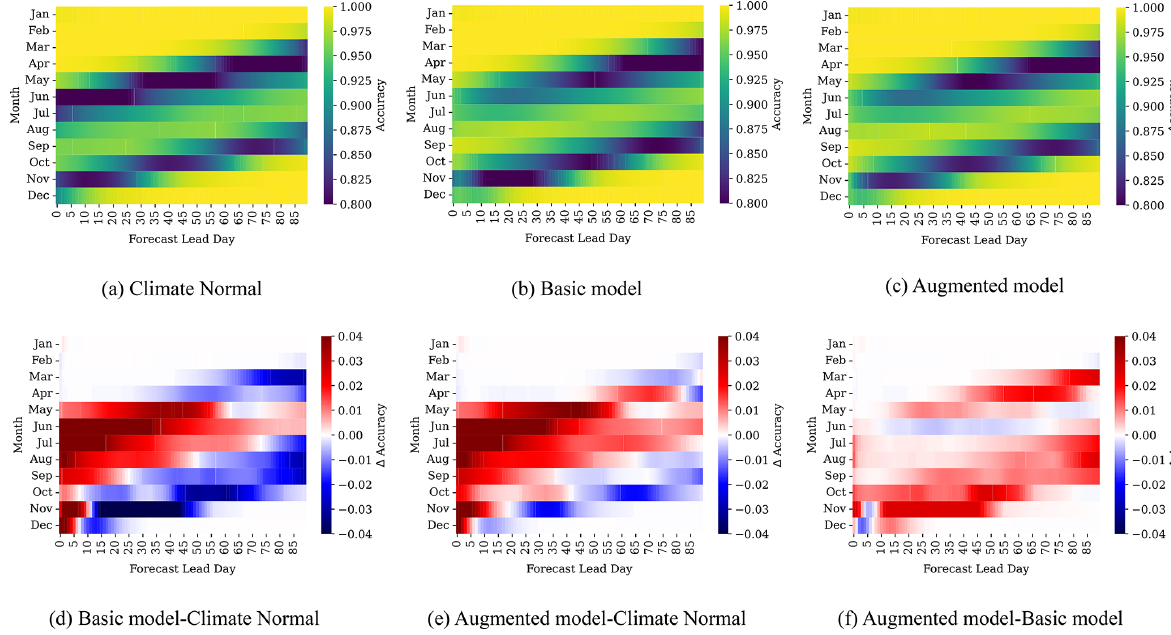
Figure 4. Binary accuracies as a function of lead time. Top row panels a–c show the binary accuracy of each model, while bottom row panels d–f show the differences in binary accuracy between the models. The Augmented model is trained with additional 90d Climate Normal input. Most differences are observed in the breakup and freeze-up seasons.